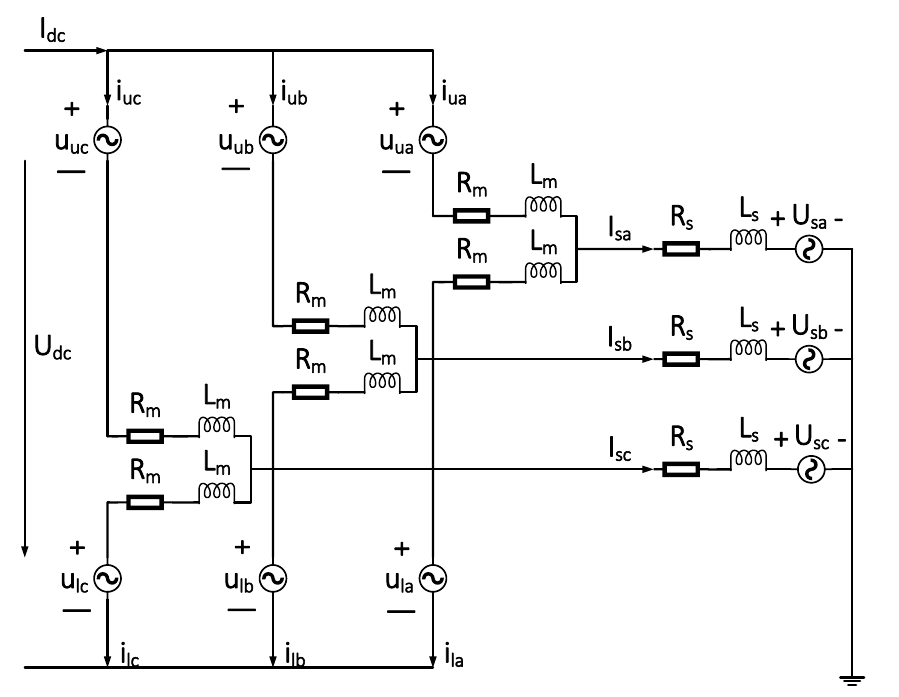
Figure 4. MMC three-phase equivalent model.